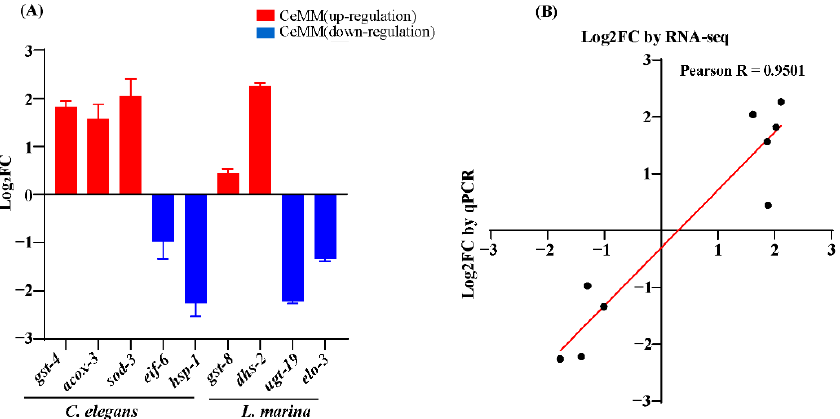
Figure 7. Validation of the RNA-seq results using qPCR. ( A ) qPCR analysis of the genes of interest identified from the RNA-seq results. Log2FC: Log2(Fold Change). All data shown here are mean ± SEM. ( B ) Correlation analysis of the results of RNA-seq and qPCR for the genes of interest. Each dot represents a gene, and detailed information is shown in Supplementary File S3. Pearson R = 0.9501, with a p -value of <0.0001.